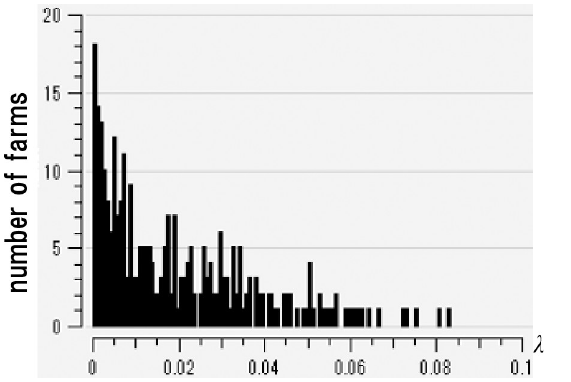
Fig 1. Distribution of λ (scattering index) on the day of infection for each farm estimated from the data. The distribution is based on the only official FMD infection data in Japan (2010 data for Miyazaki prefecture). The date on which the individual farms changed to infectivity was estimated from the day of infection indicated by this official